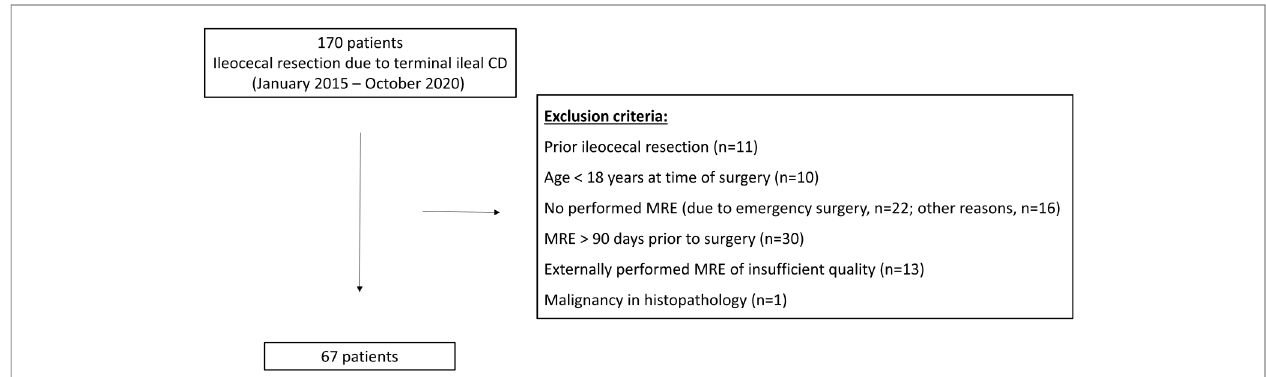
FIGURE 1 | Flowchart of patient recruitment. The process of patient selection with the respective number of patients for each exclusion criterion is